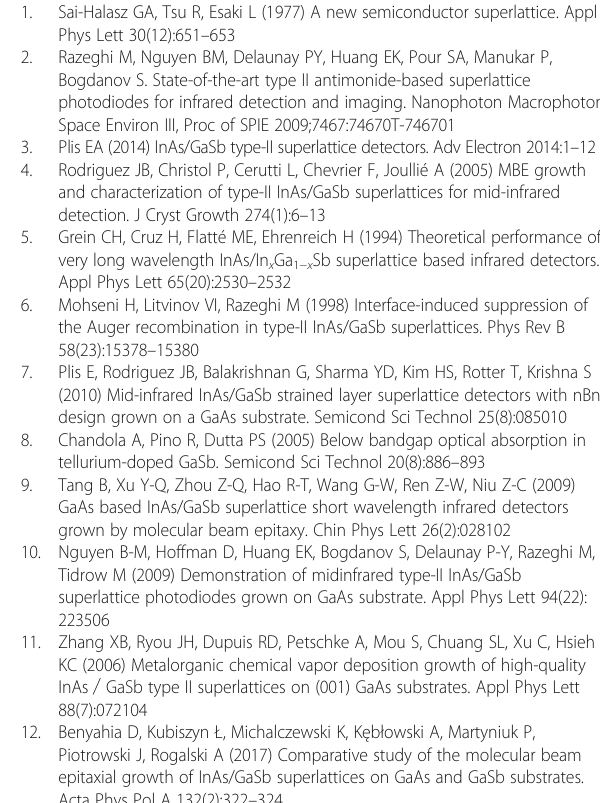
one thermal energy associated to one impurity